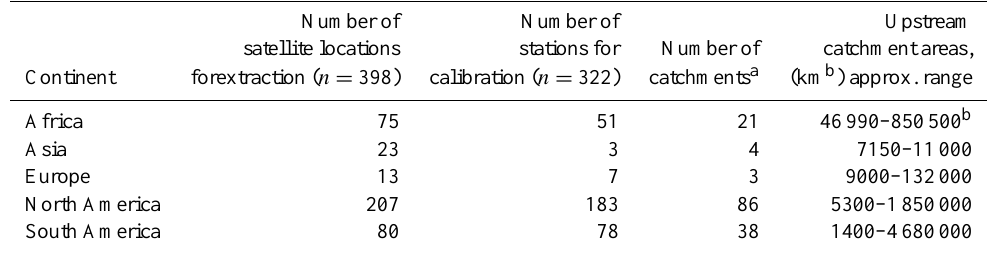
Table 1. Number of catchments by continent and range of upstream areas for the located stations.